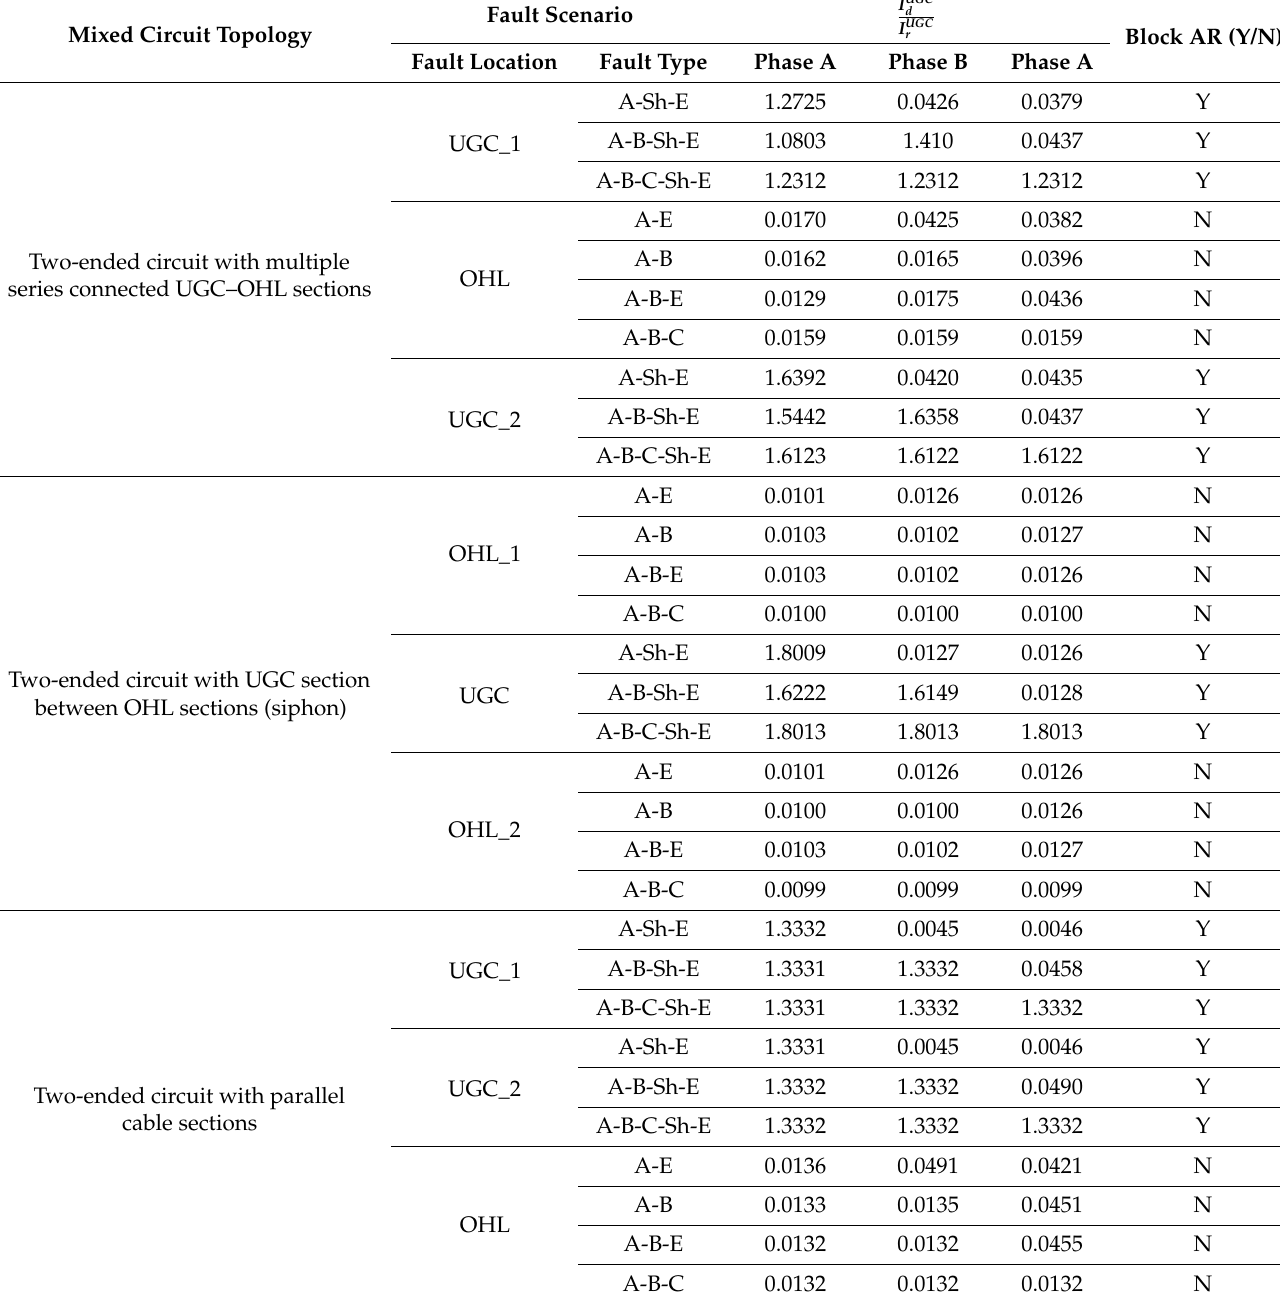
Table 2. Performance of the proposed scheme for different mixed circuit